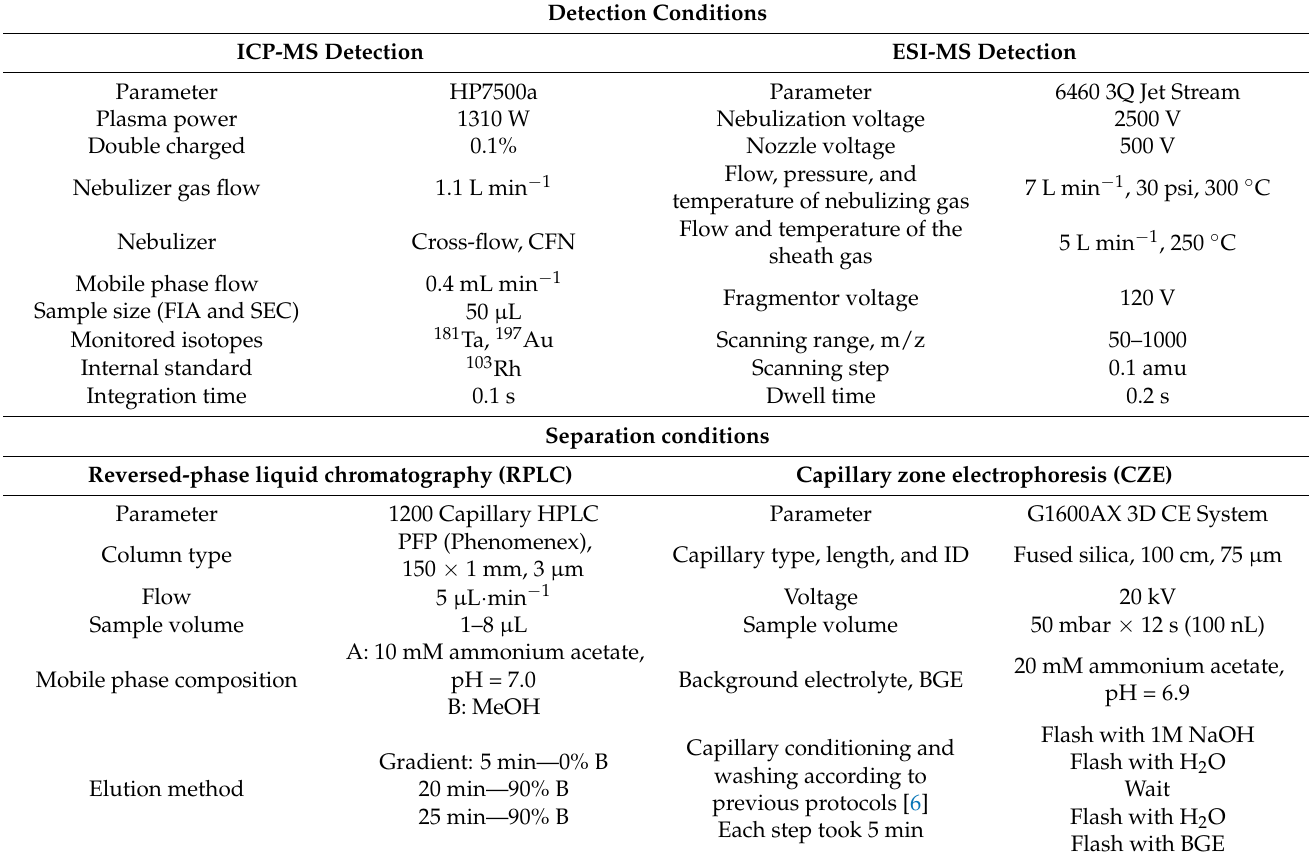
Table 2. Optimal parameters for separation and detection of peptides and their adducts with gold